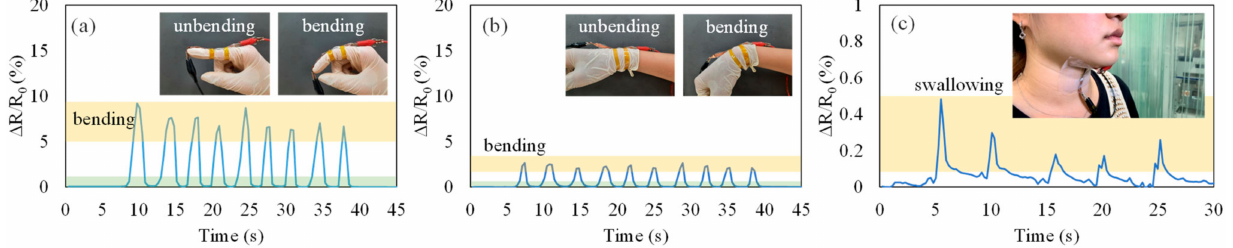
Figure 14. Detection of human motion using the developed LIG strain sensor for ( a ) finger-bending motion, ( b ) wrist-bending motion, and ( c ) throat-swallowing